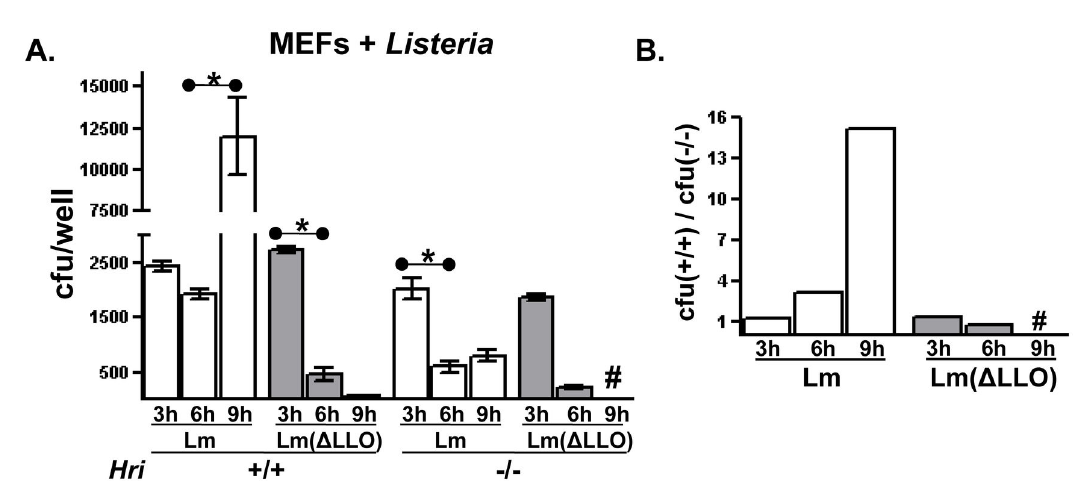
Figure 4. Absence of HRI reduces the intracellular proliferation of Listeria . ( A ) Cultured Hri +/+ and -/- MEFs were infected with either wild-type L. monocytogenes (Lm) or a strain lacking the virulence factor listeriolysin O (ΔLLO). Following a 1.5 hr attachment and invasion period and a 1.5 hr treatment with an antibiotic to kill non-internalized Lm (3 hr total), internalized Lm were enumerated either immediately (3 hr) or at the indicated time points by lysing the cells and determining the colony forming units (cfus) by plating (Using two-tailed student t test: *, P < 0.05; #, below level of detection). ( B ) Derived from the data shown in ( A ), the ratio between cfus recovered from Hri +/+ and -/- cells infected with either Lm or Lm(ΔLLO) at each time point (#, below the level of